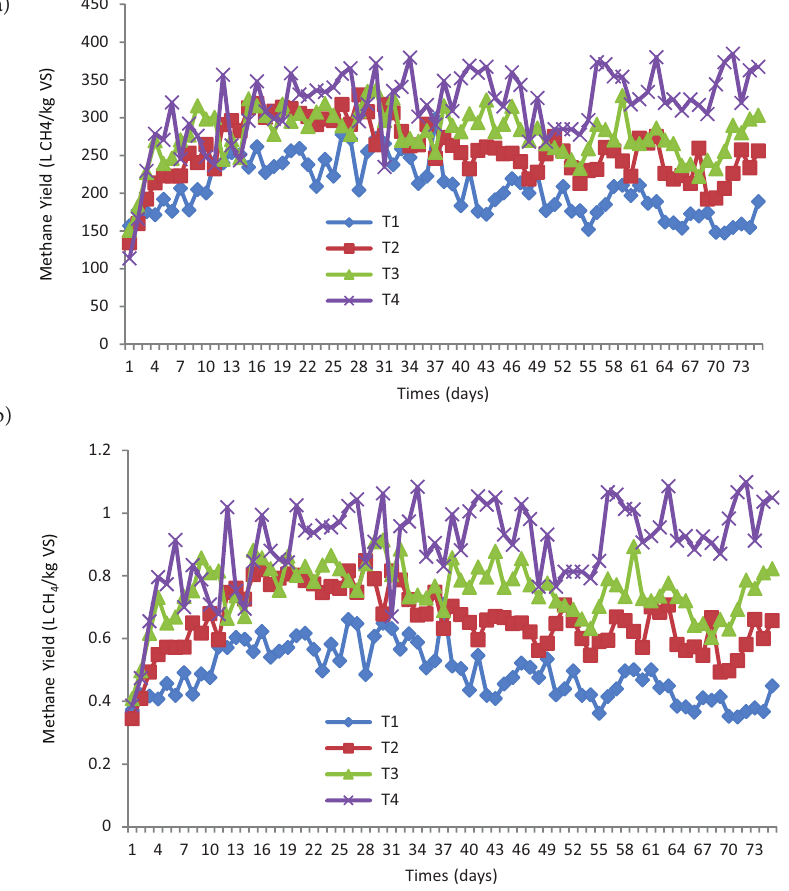
Figure 2. a) Methane yield per kg VS added; b) Methane yield per digester volume